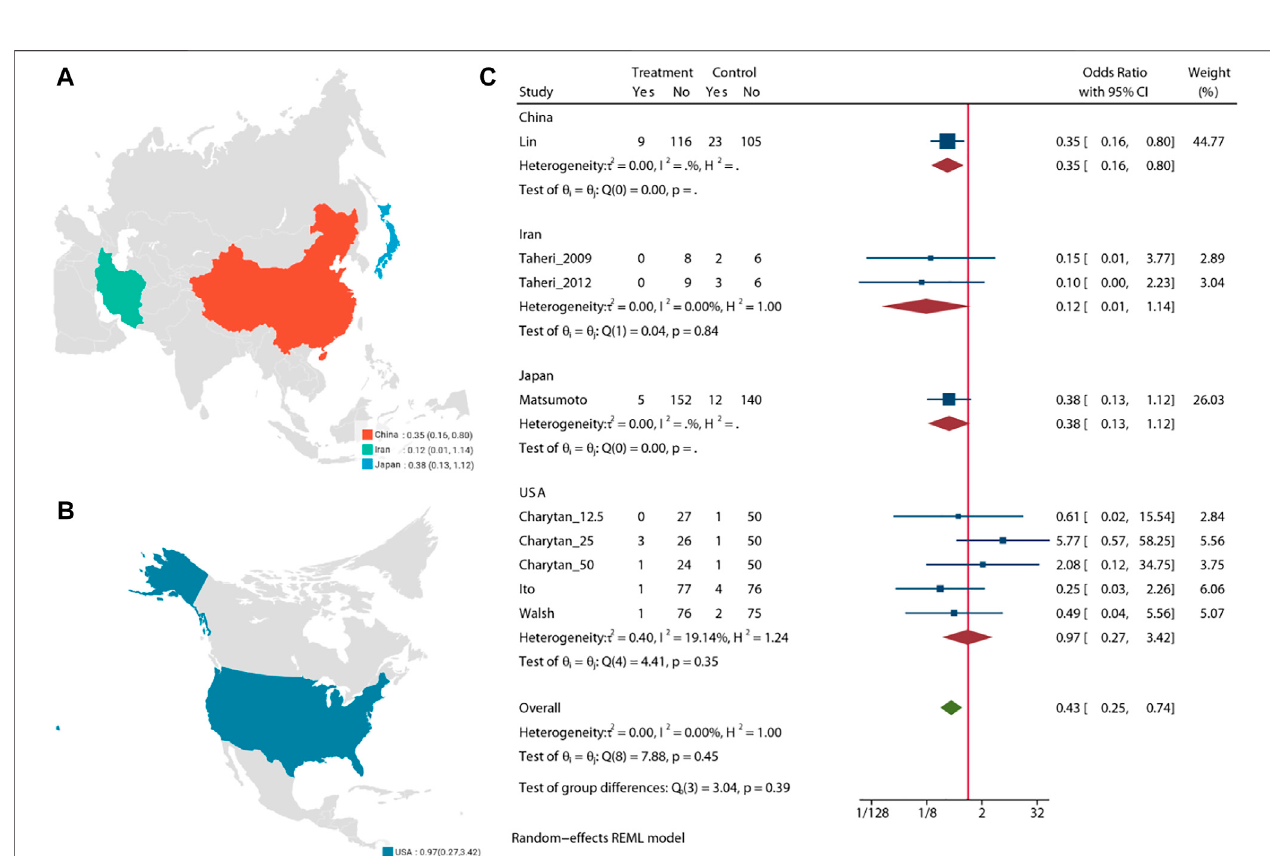
FIGURE 5 | Choropleth map of cardiovascular mortality.